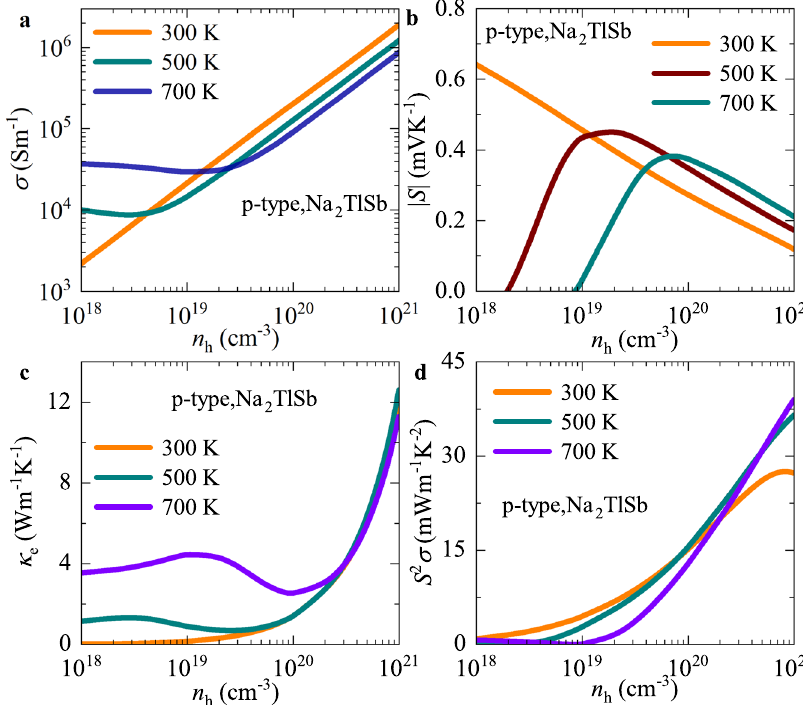
Fig. 6 Electronic transport parameters. The calculated electronic transport parameters for p-type Na 2 TlSb at 300, 500, and 700 K. a Electrical conductivity σ . b The Seebeck coef fi cient ∣ S ∣ . c The electronic thermal conductivity κ e . d TE power factor. The SOC is also included in the